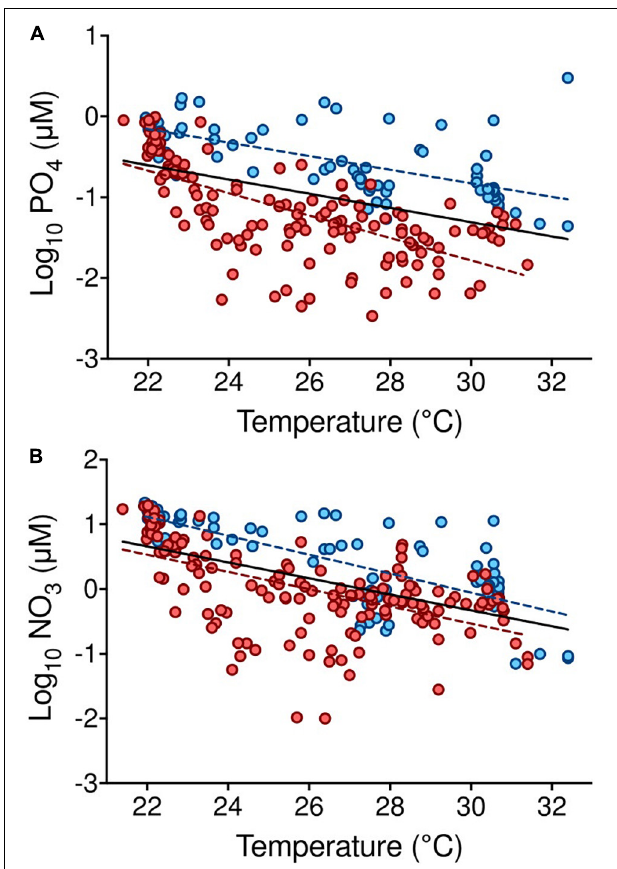
FIGURE 3 | Relationship between nutrient concentrations and seawater temperature in the Red Sea. (A) Relationships between temperature ( ◦ C) and PO 4 ( µ M) including all stations (black line, log 10 PO 4 ( µ M) = 1.34–0.09 . Temperature ( ◦ C); R 2 = 0.19, F ratio = 50.4, p < 0.0001), and considering the southern ( < 19 ◦ N, as defined in Kheireddine et al., 2017) (blue symbols and discontinuous line, log 10 PO 4 = 1.7–0.08 . Temperature, R 2 = 0.38, p < 0.0001) and northern ( > 19.1 ◦ N) (red symbols and discontinuous line, log 10 PO 4 = 2.4–0.14 . Temperature, R 2 = 0.44, p < 0.0001) areas separately; (B) relationship between temperature ( ◦ C) and NO 3 ( µ M), including all stations (log 10 NO 3 ( µ M) = 3.37–0.12 . Temperature, R 2 = 0.3, F ratio = 93.1; p < 0.0001), with no significant relationship when considering the northern and southern areas separately. Colors and symbols as described for panel (A)